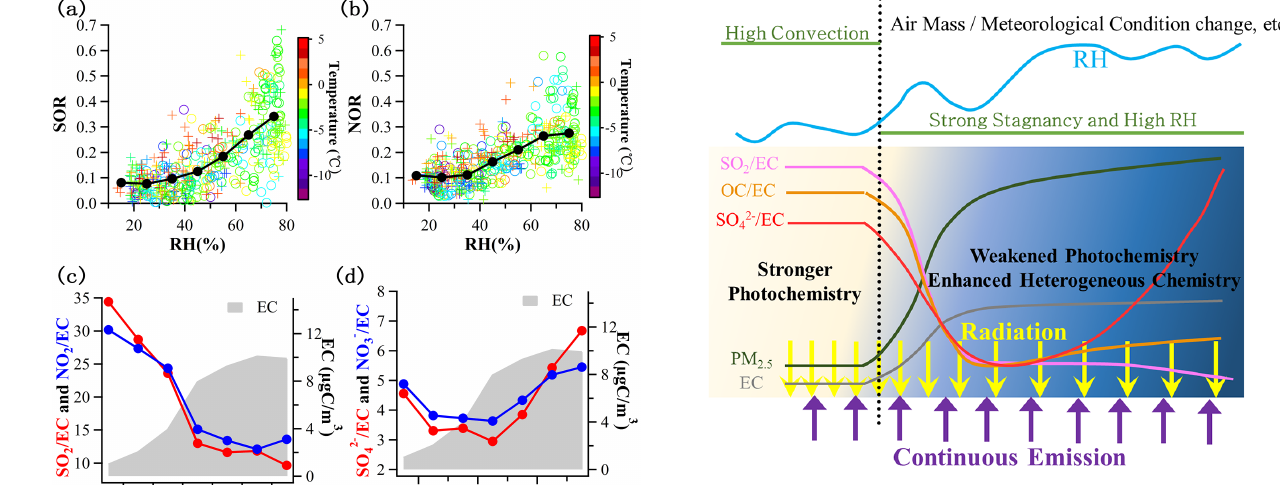
Figure 12. Conceptual model of atmospheric chemistry during the heavy pollution events. The dotted black line indicated the meteo- rology changed from a convection-favoring condition to a stagnant Figure 11. Importance of heterogeneous chemistry in sulfate and nitrate formation. (a–b) Hourly SOR and NOR plotted against RH, colored with temperature. (c–d) EC-scaled precursors (SO 2 and ) plotted against RH. EC con- NO 2 ) and products (SO 2 − and NO − 4 3 centrations at different RH levels were shown for reference.